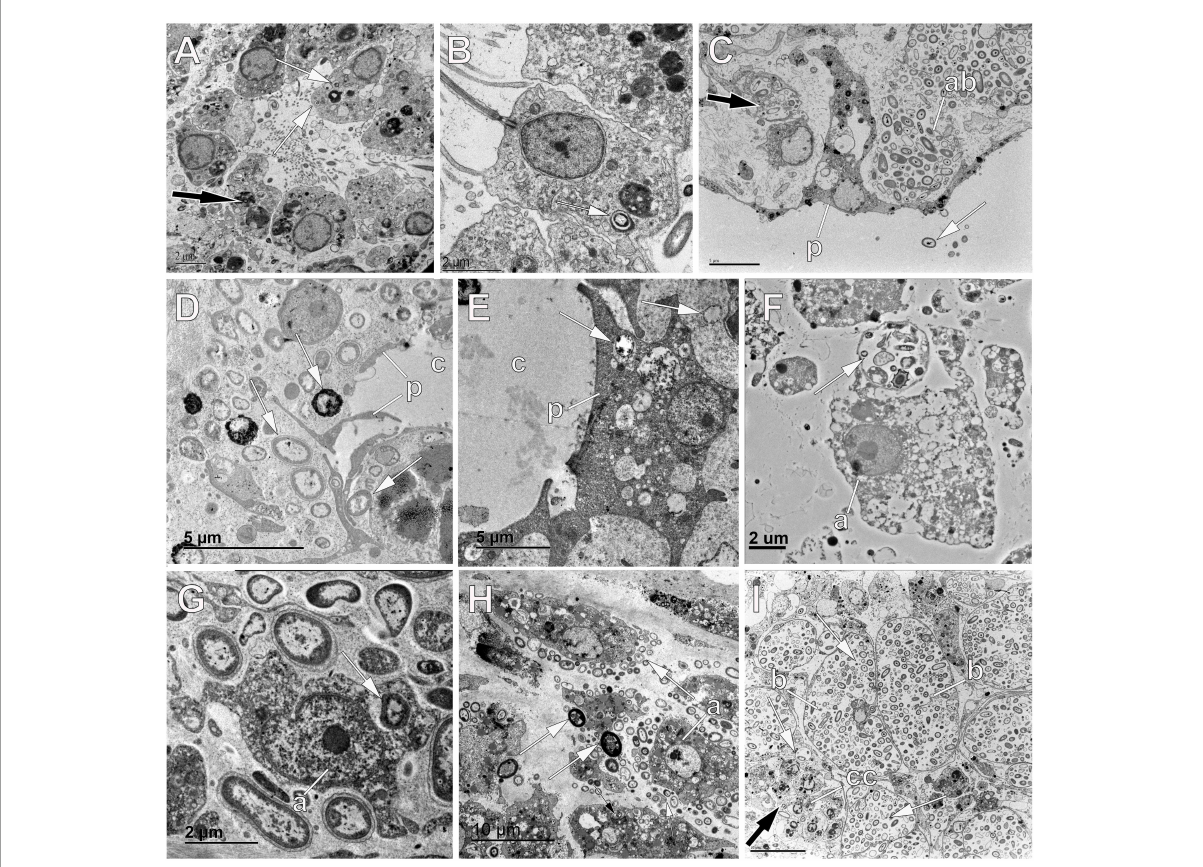
FIGURE2 Main pathways for acquisition of symbionts in sponges. (A) Choanocyte chamber showing choanocytes phagocytosing intact bacteria (white arrows) and digested bacteria in vesicles (black arrow) in the poecilosclerid Crambe crambe . (B) Choanocyte of the homosclerophorid Corticium candelabrum showing a vesicle containing an intact bacterial cell (white arrow). (C) Endopinacoderm of the haplosclerid Petrosia ficiformis showing a pinacocyte cell (p) engulfing bacteria (black arrow) that are accumulated below the pinacoderm in the mesohyl (ab). Note the presence of bacteria (white arrow) in the canal. (D) Endopinacoderm lining a canal (c) in the chondrosiid Chondrosia reniformis . Note the pinacocyte (p) opening toward the canal and the symbiotic bacteria (white arrows) in the mesohyl. (E) Endopinacoderm lining a canal (c) in the chondrosiid C. reniformis and showing a pinacocyte (p) engulfing bacteria that are later seen in the mesohyl (white arrows). (F) Archaeocyte (a) in the suberitid Halichondria panicea engulfing a vesicle containing bacteria (white arrow). (G) Archaeocyte (a) in the chondrosiid C. reniformis containing bacteria within a vesicle (white arrow). (H) Archaeocytes (a) in the dyctioceratid Ircinia fasciculata showing symbionts (white arrows) surrounding them product of chemotaxis. Note that some archaeocytes contain vesicles digesting symbionts (black arrow). (I) Bacteriocytes (b) in the haplosclerid P. ficiformis containing abundant symbionts in cellular pockets (white arrows). Note the choanocyte chamber close to the bacteriocytes showing bacteria within vesicles of the choanocyte (black